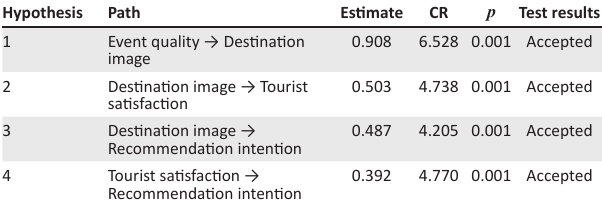
TABLE 5: Mediating effects of tourist satisfaction. TABLE 4: Results of structural equation modelling analysis and hypothesis